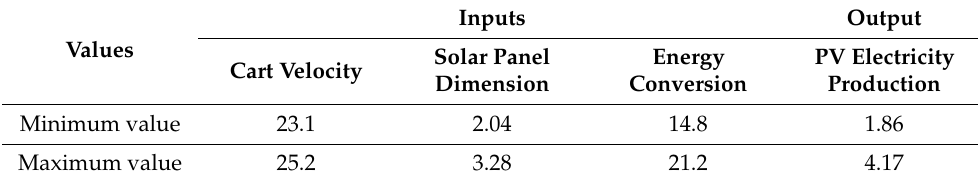
Table 6. Output results from the proposed fuzzy system.